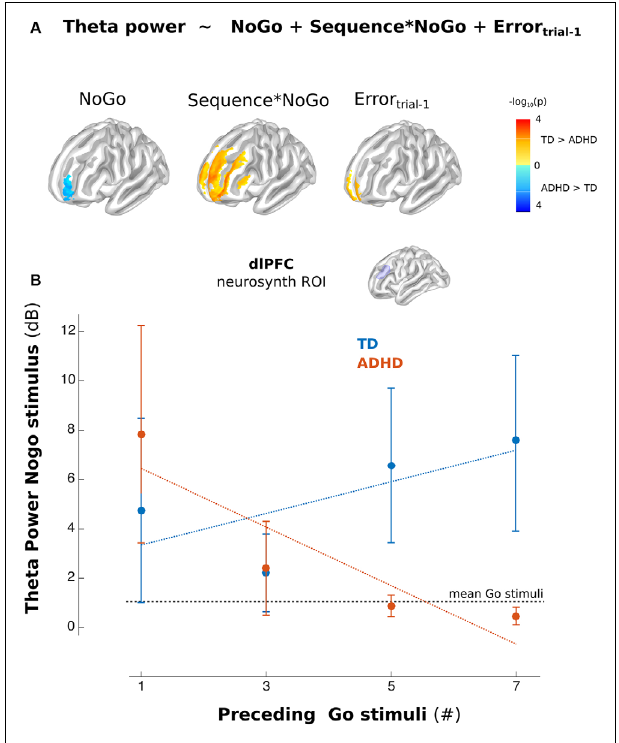
FIGURE 4 | Theta activity in the left Lateral PFC (lPFC). (A) Model used in Time-frequency analysis. The color indicates the differences between the corresponding regressors between groups (Blue ADHD>TD and Red TD>ADHD, p < 0.01 uncorrected). (B) Mean of the power of the lPFC (dorsolateral PFC from Neurosynth) ROI for Nogo stimuli related to Go stimuli separated per sequence (illustrative propose). Error bars represent standard error of the